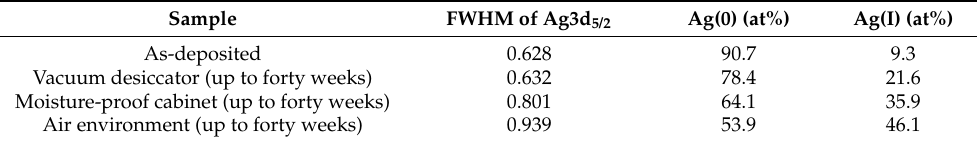
Figure 6. The high-resolution X-ray photoemission spectroscopy scanning from the Ag 3d and O 1s regions. Table 4. The compositions of Ag(0) and Ag(I) in Sample C stored in the different environments.